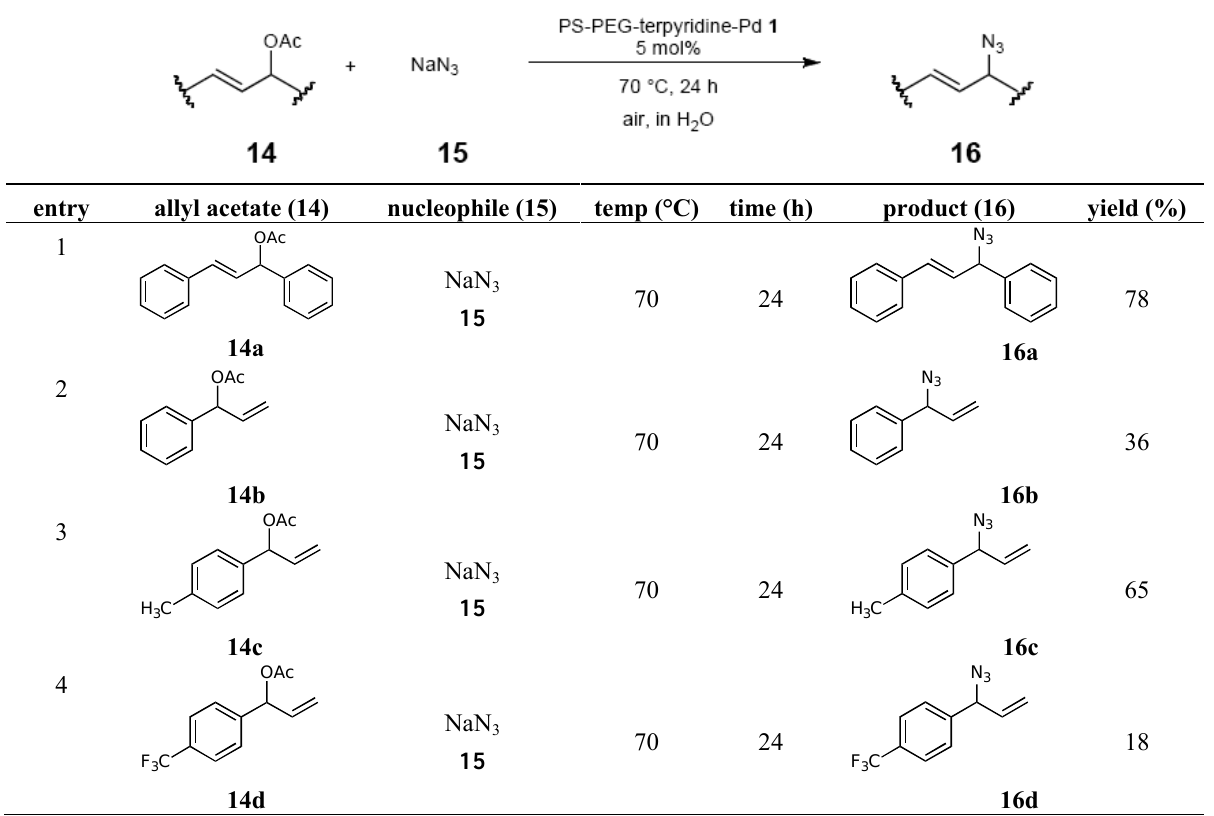
Table 4. Tsuji-Trost reaction using polymeric catalyst 1 in water a,b